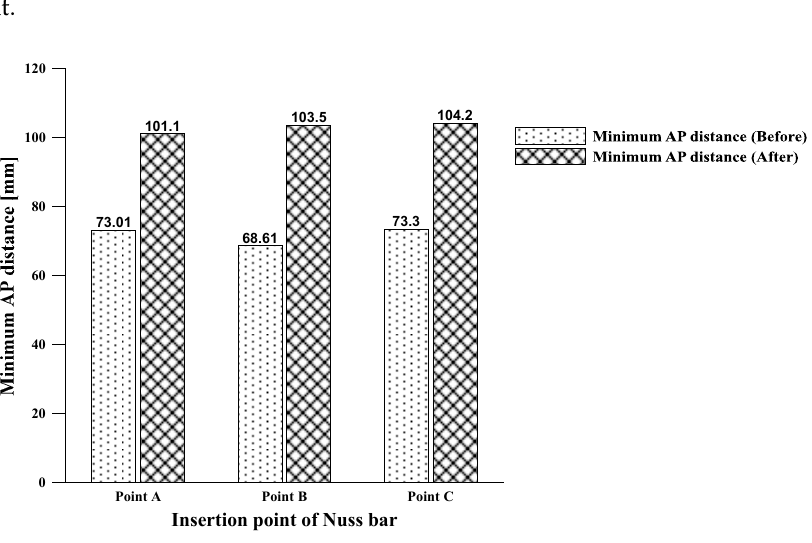
Figure 10. Minimum AP distance before and after the Nuss procedure. Values of minimum AP distance with Nuss bar insertion points are shown by histogram.